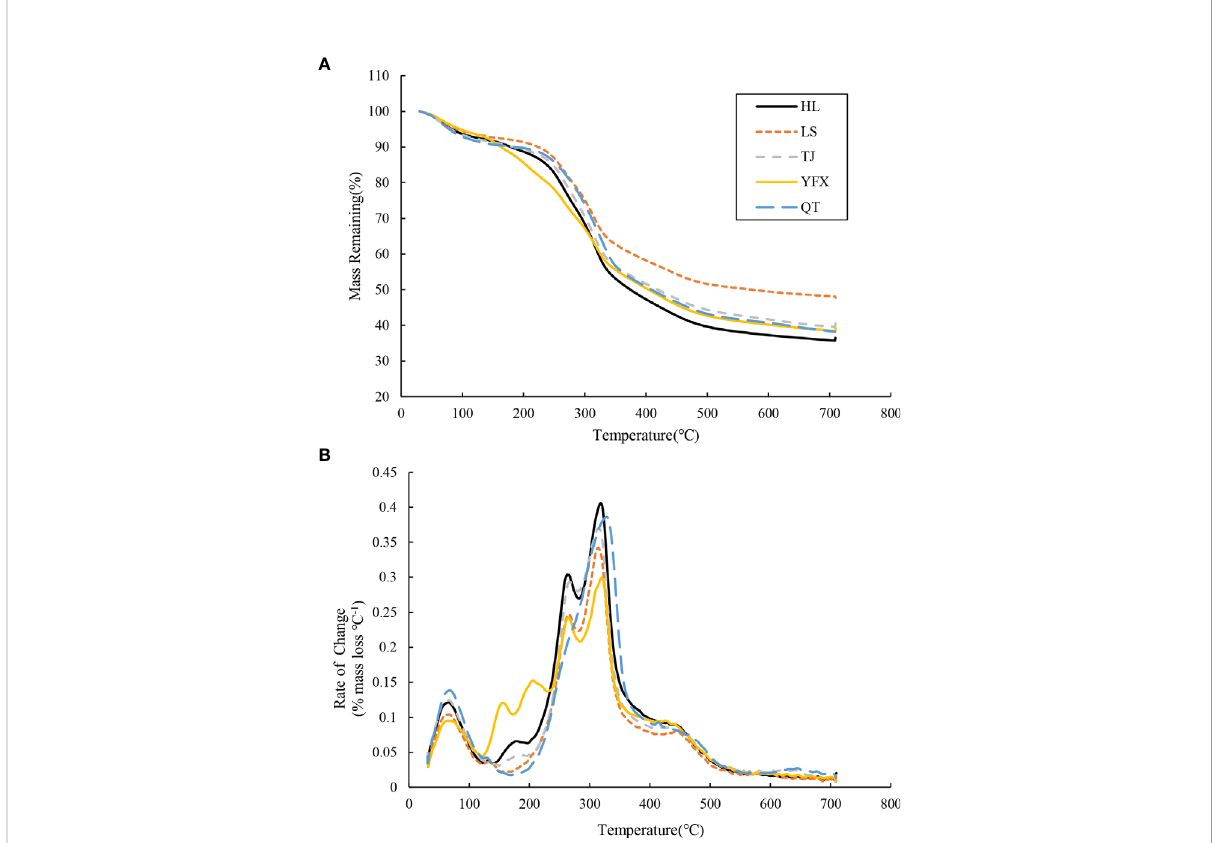
FIGURE 3 Thermograms for the seagrass among fi ve seagrass meadows, (A) % mass remaining with increasing temperature and (B) derivate rate-of- change (% mass loss per °C) with increasing pyrolysis